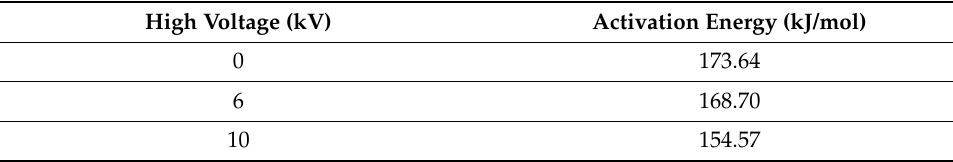
Table 4. Activation Energy (Ea).